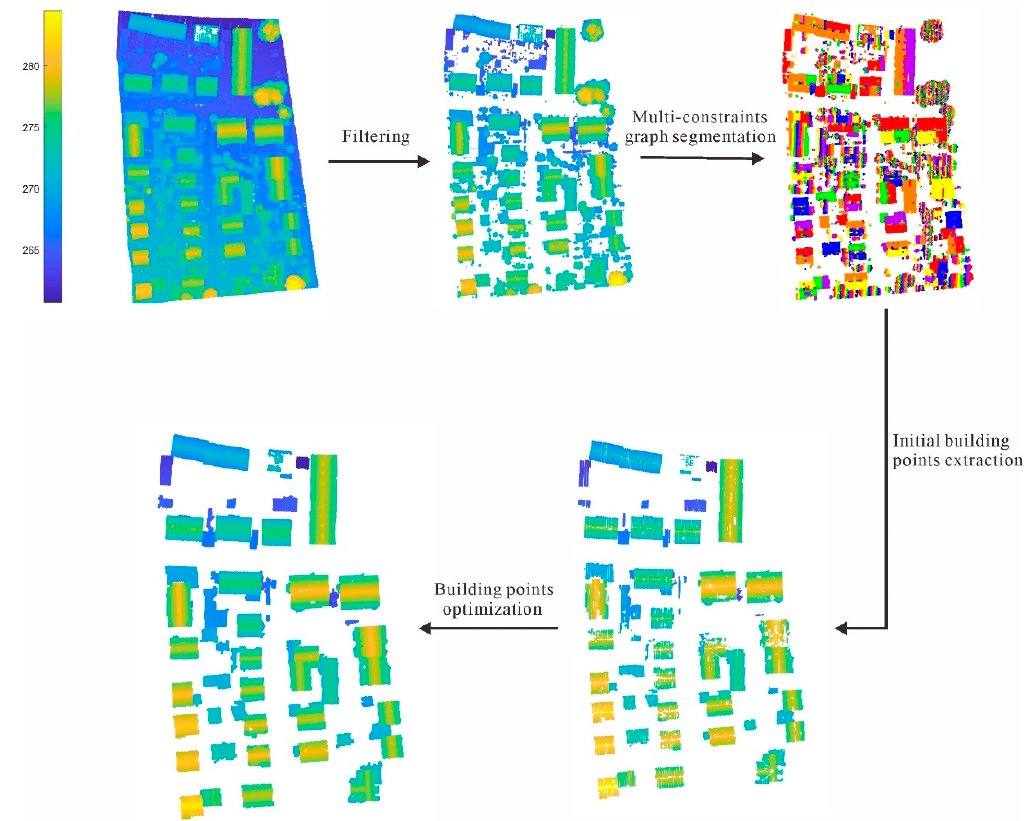
Figure 1. Flowchart of the proposed method. Filtering is first applied for removing the ground points. Then, the proposed multi-constrains graph segmentation is adopted to achieve the segmentation results. According to the geometric features, the initial building points can be obtained. Finally, an optimization step is applied to obtain the final building extraction results.